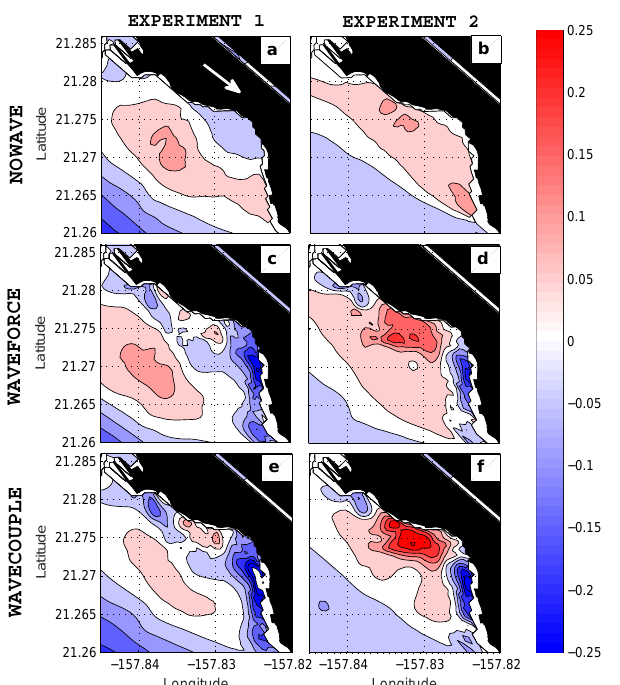
Figure 7. Time-averaged cross-shore currents (ms − 1 ) in Waikiki region for experiment 1 (a, c, e) and experiment 2 (b, d, f) from the three modeling strategies. The colors indicate the current intensity (ms − 1 ) with contours every 0.05ms − 1 . It is interesting to observe the appearance of return flow cells perpendicular to the coast in the simulations that consider the effect of the surface waves. Both the WAVEFORCE and WAVECOUPLE simulations resolve the mod- ification of the nearshore circulation pattern by the waves, with WAVECOUPLE presenting stronger currents. The white arrow in panel (a) shows the direction of positive cross-shore